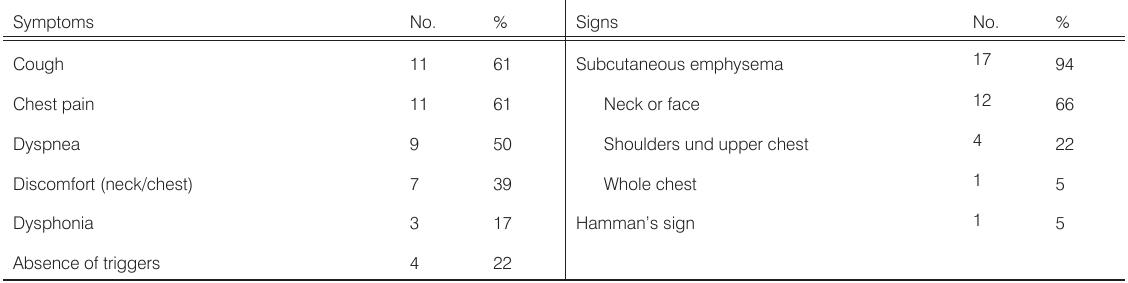
Table 2. Symptoms and Signs